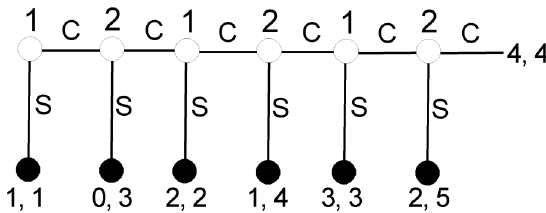
Figure 5. The game of Centipede with three rounds